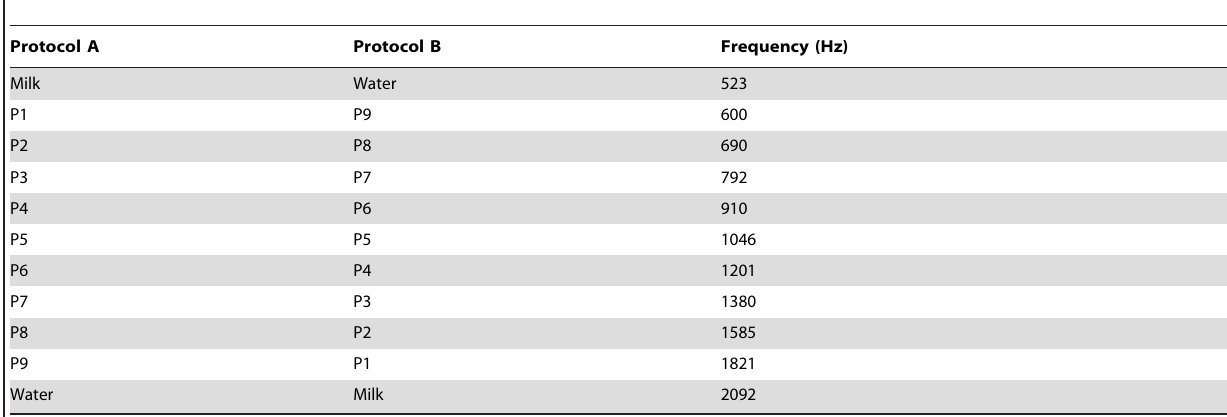
Table 2. Frequency (Hz) of auditory tones used in training and